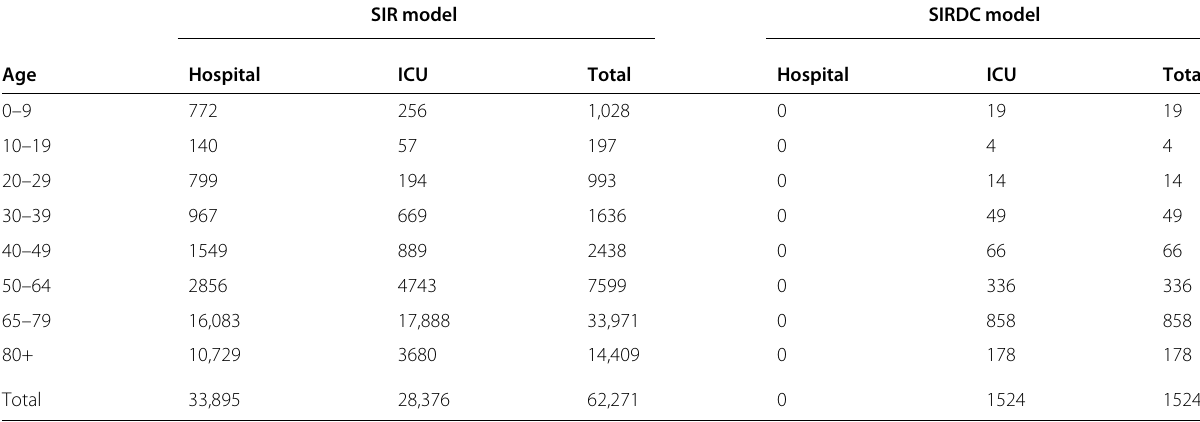
Table 7 Overflow deaths (infections until September